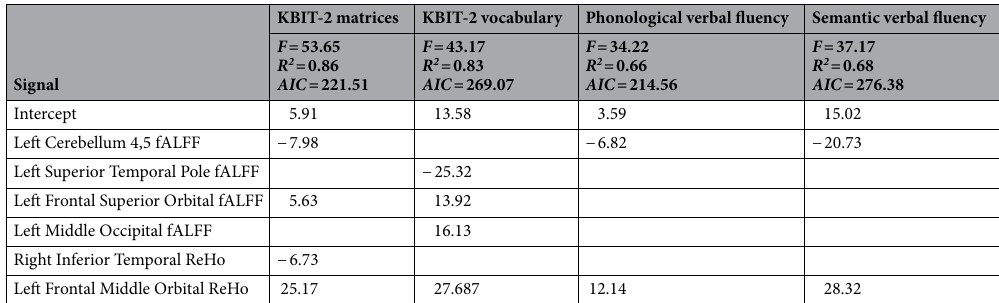
Table 4. Parameter estimation (β) of the best stepwise linear model for each significant cluster in fALFF. They all had a p < 0.001 in the model (df = 1; 33) and a p > 0.05 in Anderson’s Darling test of normality, the Ramsey Regression Equation Specification Error (RESET) test, Durbin Watson’s test, and the Breusch–Pagan test. F ANOVA, AIC Akaike information criterion.